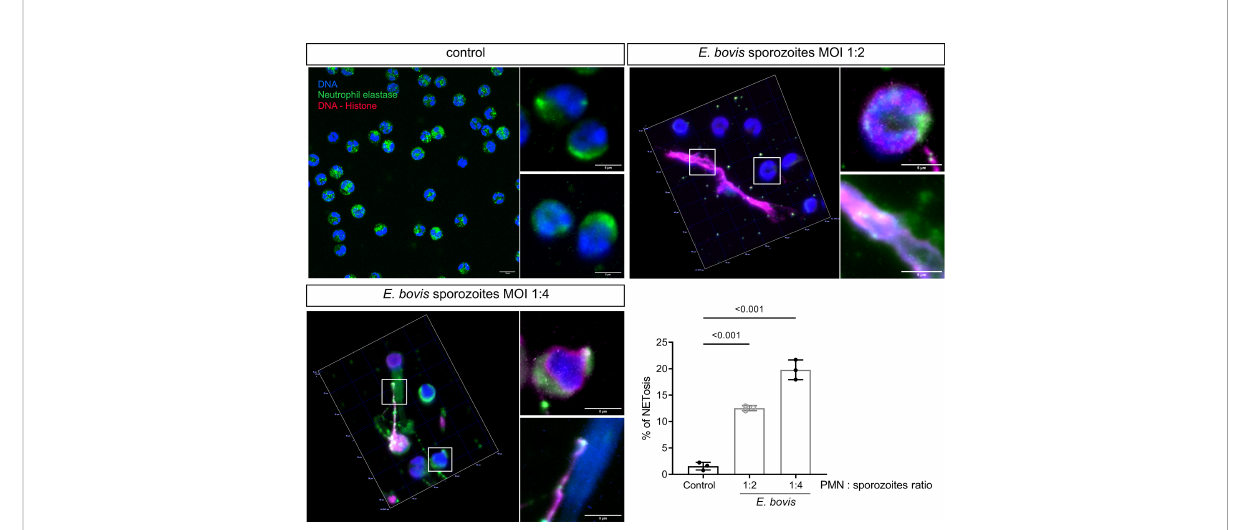
FIGURE 4 E. bovis sporozoite-induced NET formation is dependent on the PMN:parasite ratio. PMNs (2.5 × 10 5 ) were seeded in poly-L-lysin-coated coverslips, and E. bovis sporozoites were added at 1:2 and 1:4 PMN:sporozoite ratios. After 120 min of co-incubation, the samples were fi xed and then immunodetection of DNA – histone complex (red) and neutrophil elastase (NE; green) was performed. DNA was stained with DAPI (blue). Exemplary illustrations of unstimulated PMN PMN confronted with E. bovis sporozoites at 1:2 and 1:4 ratios. The percentage of cells forming NETs was quanti fi ed by a semiautomatic method and represented as mean ± SEM . p-values were calculated using a repeated measures (paired) ANOVA followed by a Dunnett ’ s multiple-comparison test analysis (n = 3)